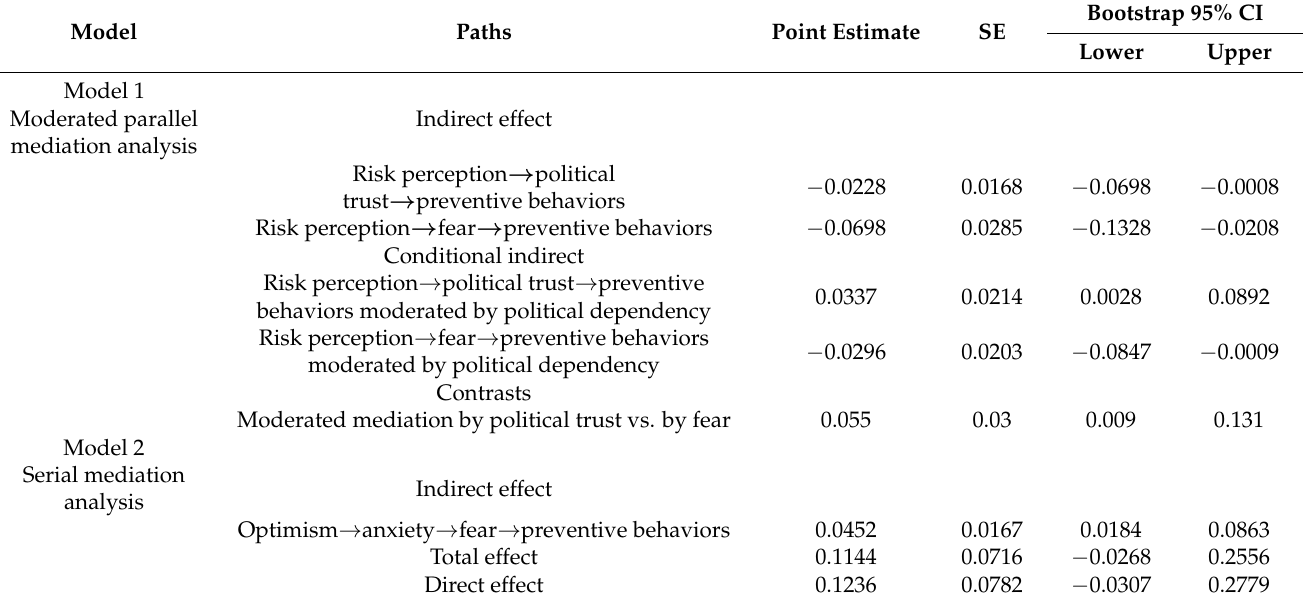
Figure 1. Conceptual model; the indirect effect of risk perception on compliance with preventive behaviors via political trust and fear, as moderated by government dependency. Table 2. Bootstrap moderated parallel mediation effect and serial mediation effect.